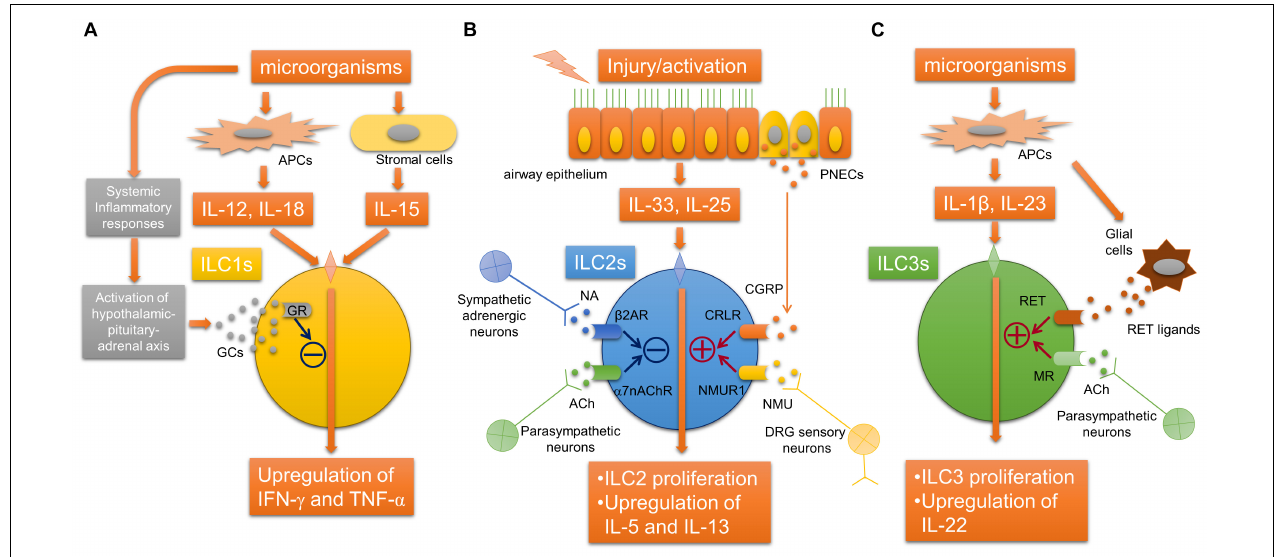
FIGURE 2 | Neuroimmune interaction regulating innate lymphoid cells. (A) Glucocorticoids derived from hypothalamic-pituitary-adrenal axis stimulated by inflammatory mediators during systemic inflammation bind to GRs in ILC1s, which inhibits the release of IFN- γ . (B) The activation of ILC2s by epithelial alarmin cytokines is inhibited by ACh derived from parasympathetic neurons and possibly non-neuronal cells via α 7nAChR, or NA derived from sympathetic neurons via β 2 AR. In contrast, neuromedin U derived from DRG sensory neurons or CGRP derived from PNECs augments the activation of ILC2s via NMUR1 or CRLR, respectively. (C) RET ligand derived from glial cells or acetylcholine derived from parasympathetic neurons arguments the proliferation and activation ILC3s via RET or muscarinic receptors, respectively. α 7nAChR, α 7 nicotinic acetylcholine receptor; ACh, acetylcholine; APC, antigen-presenting cell; β 2 AR, beta-2 adrenergic receptor; CGRP, calcitonin gene-related peptide; CRLR, calcitonin receptor-like receptor; DRG, dorsal root ganglia; GCs, glucocorticoids; IFN- γ , interferon-gamma; ILCs, innate lymphoid cells; MR, acetylcholine muscarinic receptor; NA, norepinephrine; NMU, neuromedin U; NMUR1, neuromedin-U receptor 1; PNEC, pulmonary neuroendocrine cell; TNF- α , tumor necrosis